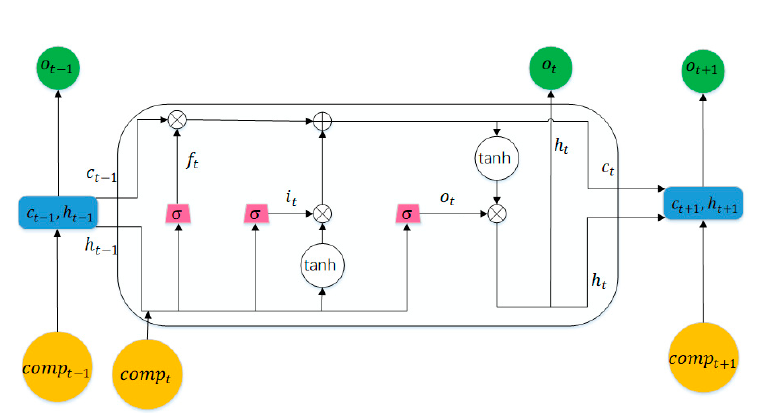
Figure 3. The structure of Long Short Term Memory.